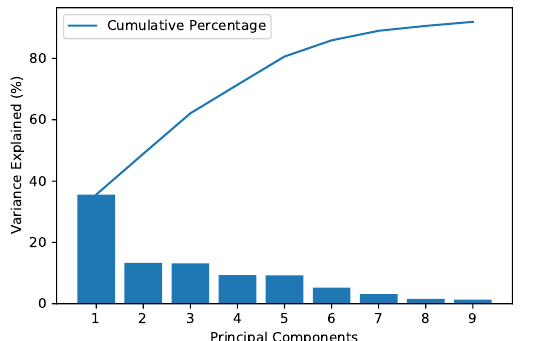
Figure 3. Cumulative percentage of variance explained by the first 10 principal components for the Greek System